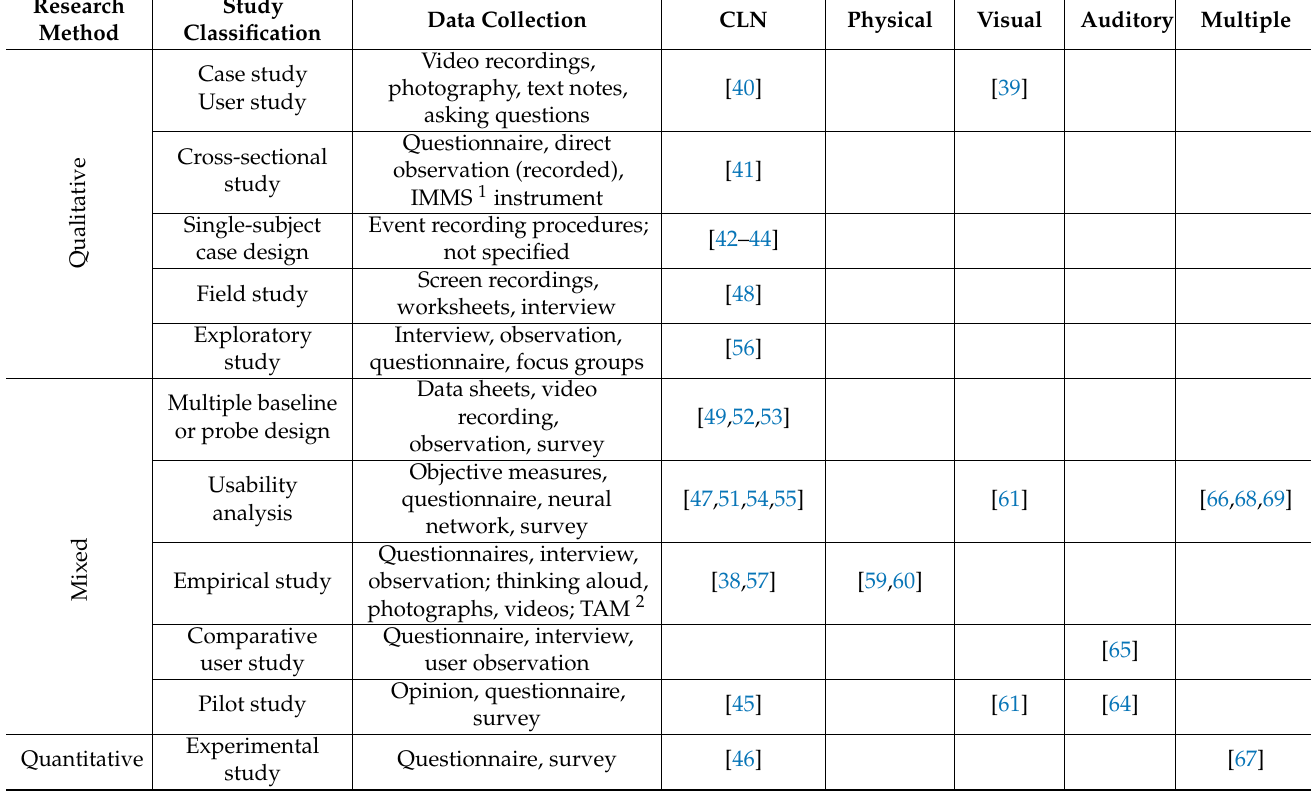
Table 5. Research methods and data-collection techniques used in AR solutions by